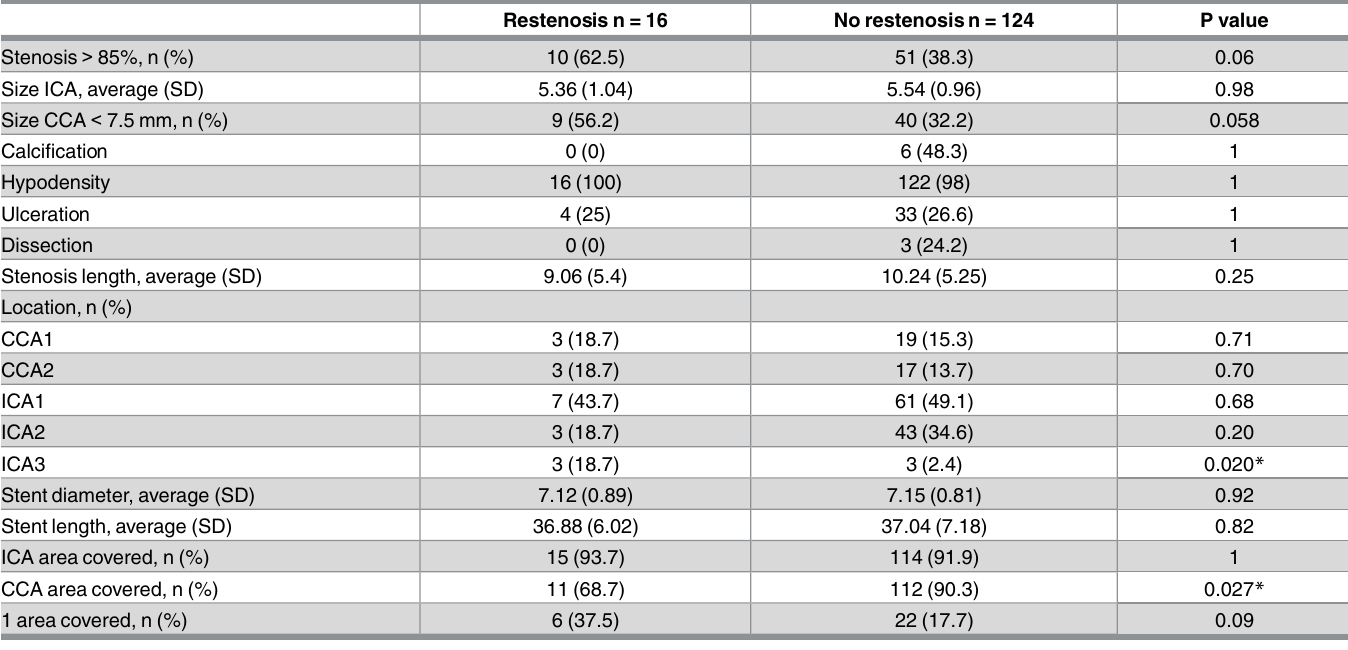
Table 4. Anatomical and Technical Factors: UnivariateAnalysis.